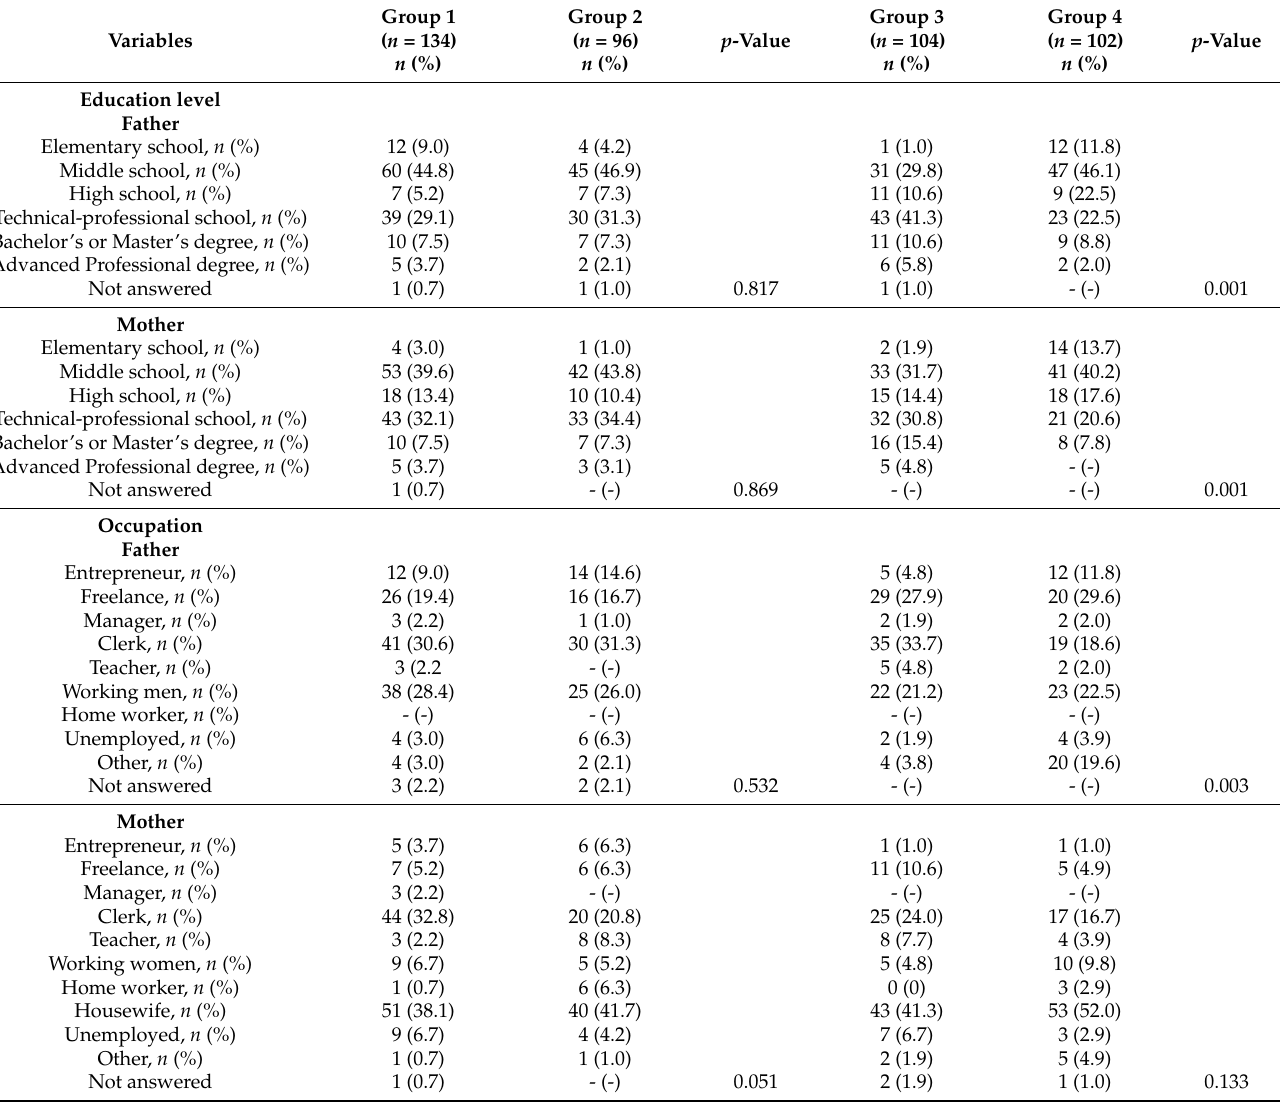
Table 2. Socio-cultural characteristics of